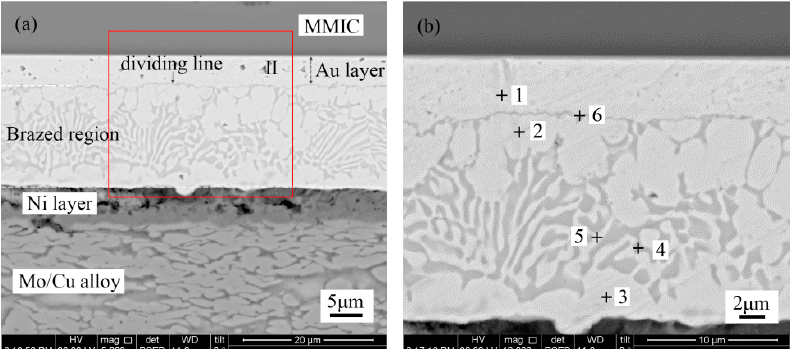
Figure 6. ( a ) Microstructure of the Au/Ti/Au|Au-Sn eutectic joint and ( b ) region II in higher Figure6. ( a )MicrostructureoftheAu / Ti / Au | Au-Sneutecticjointand( b )regionIIinhighermagnification. magnification. Table 3. Chemical composition of each region in the Au / Ti / Au | Au-Sn eutectic joint. Table 3. Chemical composition of each region in the Au/Ti/Au|Au-Sn eutectic joint. Element Composition Position Element Composition (at.%) Position